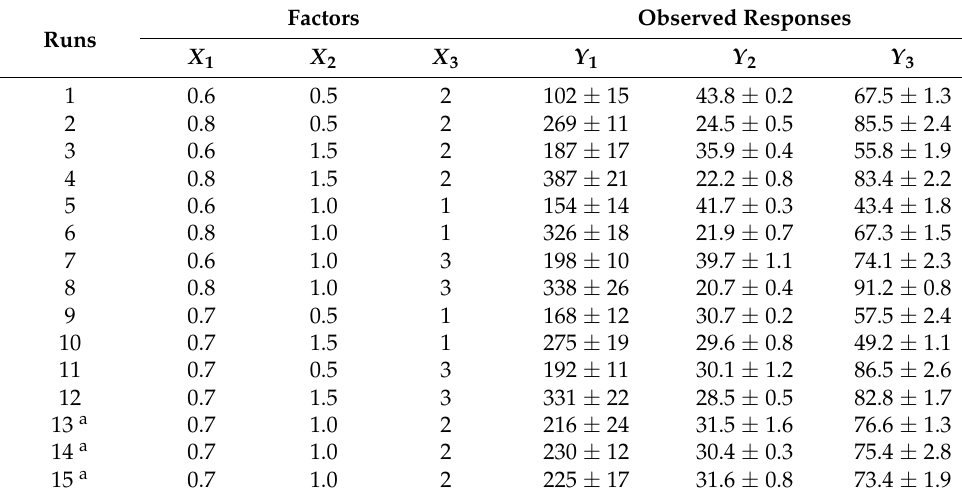
Table 2. Box–Behnken design matrices with observed response values for development and opti- mization of HHC-CS-NPs ( n = 3). Runs